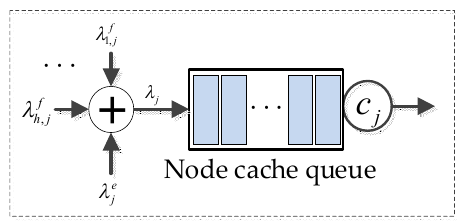
Figure 2. Node j queue model.